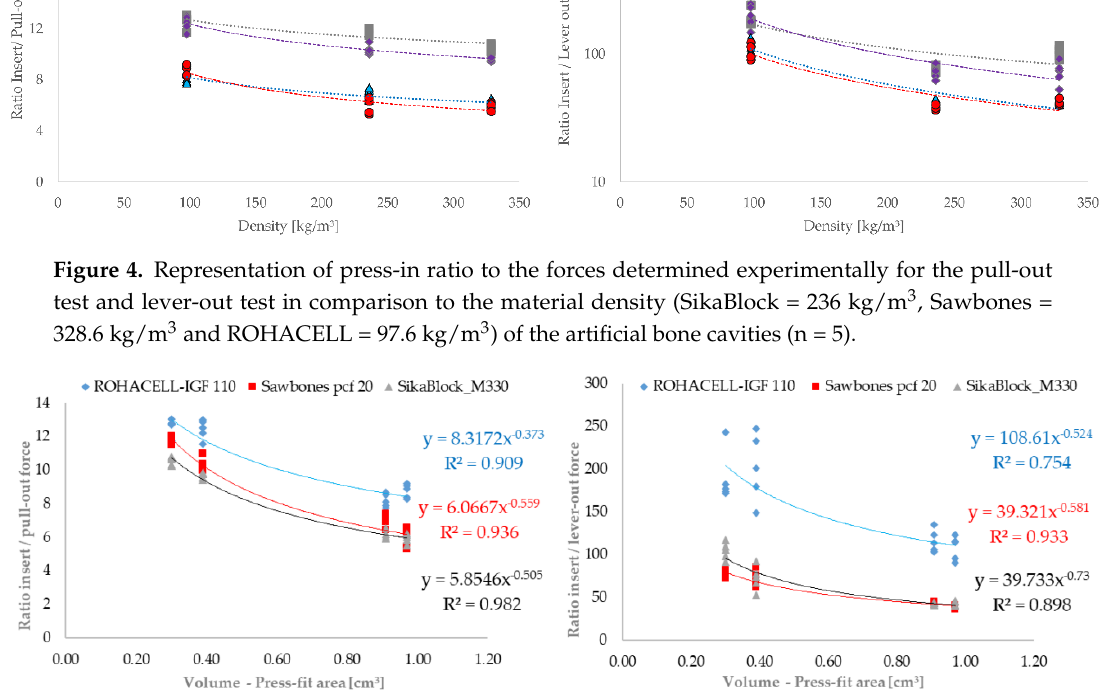
Figure 5. Representation of press-in ratio and to the forces determined experimentally for pull-out test and lever-out test in comparison to the press-fit volume of the tested acetabular cup variant (n = 5).